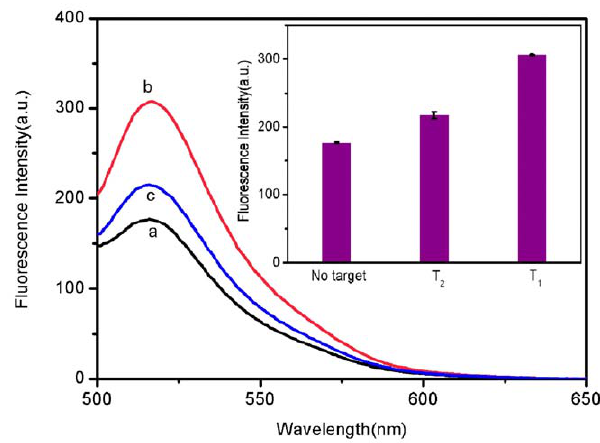
Figure 8. Performance of single-base mismatch discrimination in the presence of blood serum. Fluorescence emission spectra of P HIV (50 nM) in 40- m L blood serum and 360- m L Tris-HCl buffer containing 15 mM Mg 2 + (pH: 7.4) at different conditions: (a) P HIV + RCPNs; (b) P HIV + RCPNs + 300 nM T 1 ; (c) P HIV + RCPNs + 300 nM T 2 . Inset: fluorescence intensity histograms with error bar. Excitation was at 480 nm, and the emission was monitored at 518 nm. The error bar represents the standard deviation of three measurements.